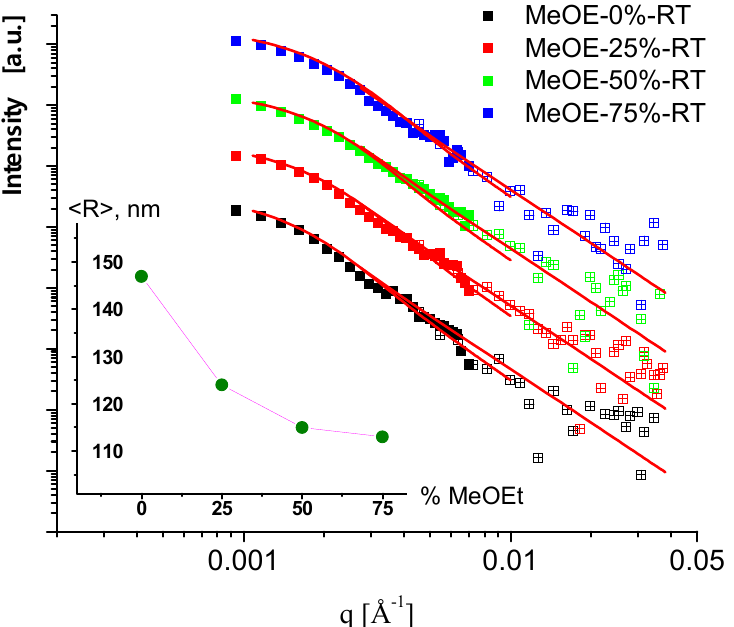
Figure 8. USANS scattering curves of samples prepared at room temperature. Symbols are the measured data, and red solid lines are the fitted model of polydisperse spheres. Data are shifted vertically. In the inset, the mean radius of the particles is shown in the function of 2-methoxyethanol content in the sol.